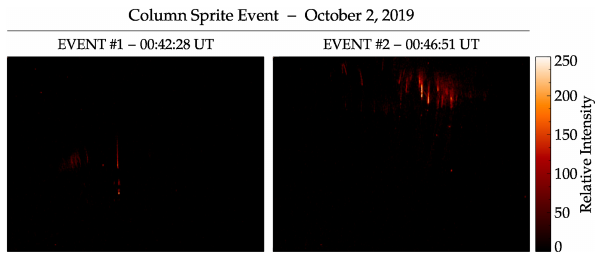
Figure 16. Image of two groups of sprites generated by the same thunderstorm that generated the CGWs observed during the night of 1 to 2 October